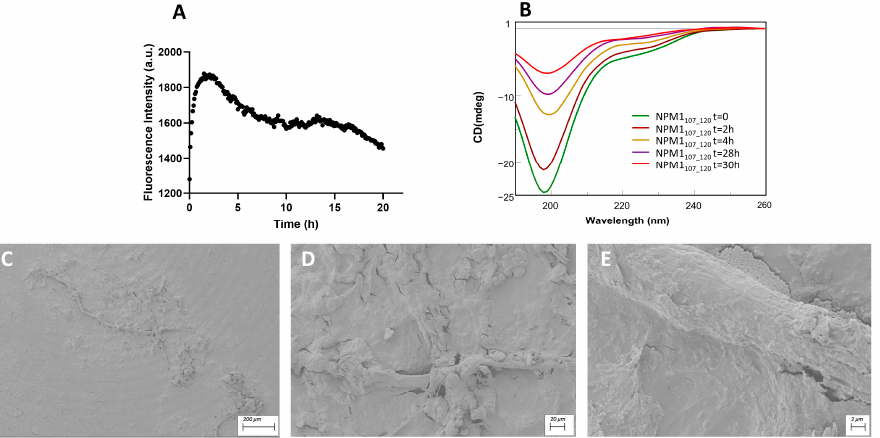
Figure 3. NPM1 69–83 characterization: ( A ) Time course of ThT fluorescence emission intensity; ( B ) CD spectra over time; ( C – E ) SEM micrographs registered at 24 h at 100, 20 and 2 µm.